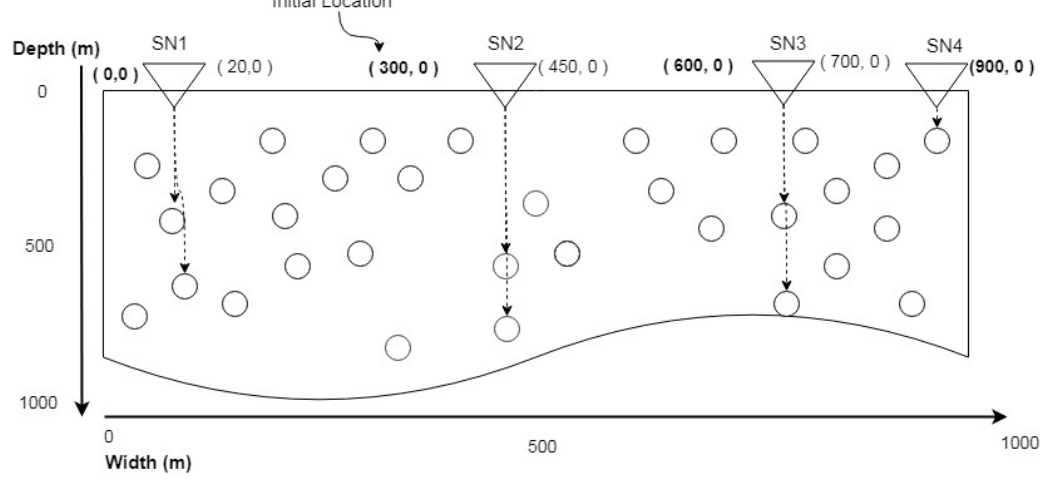
Figure 3. Assigning X axis